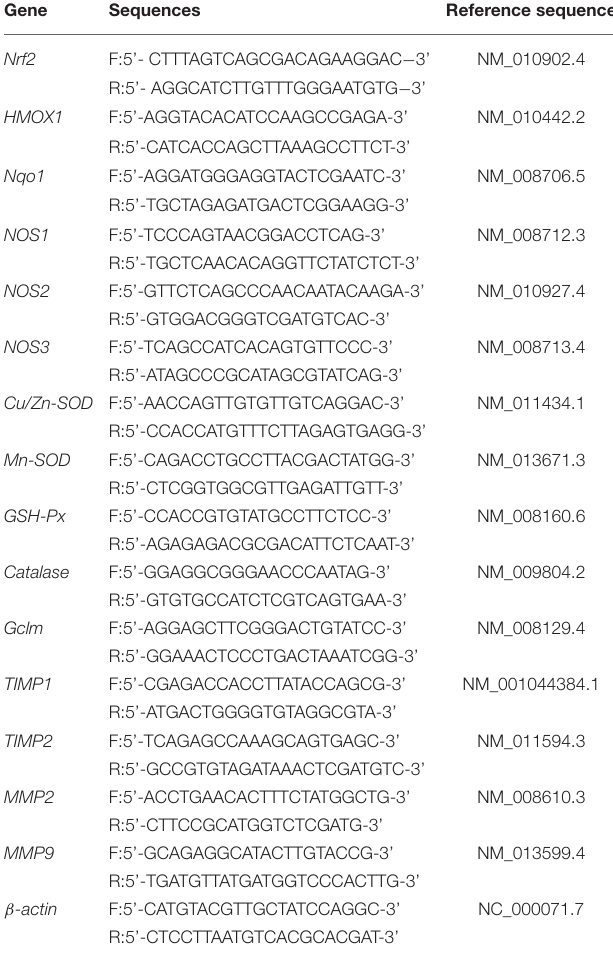
TABLE 1 | Sequences of the